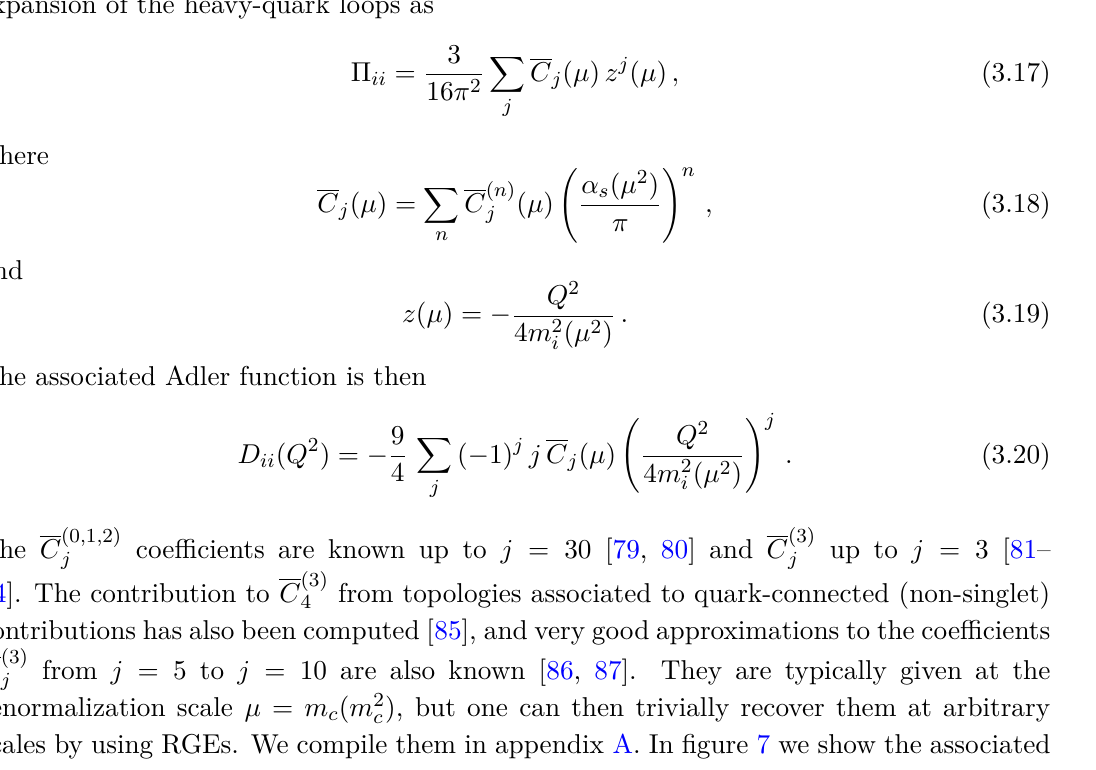
( Q 2 ) = D L,m c ( Q 2 ) + D L,m c ( Q 2 ) computed numerically and ii ii,< ii,> afterwards. c ) = 0 . 1184 has been Z